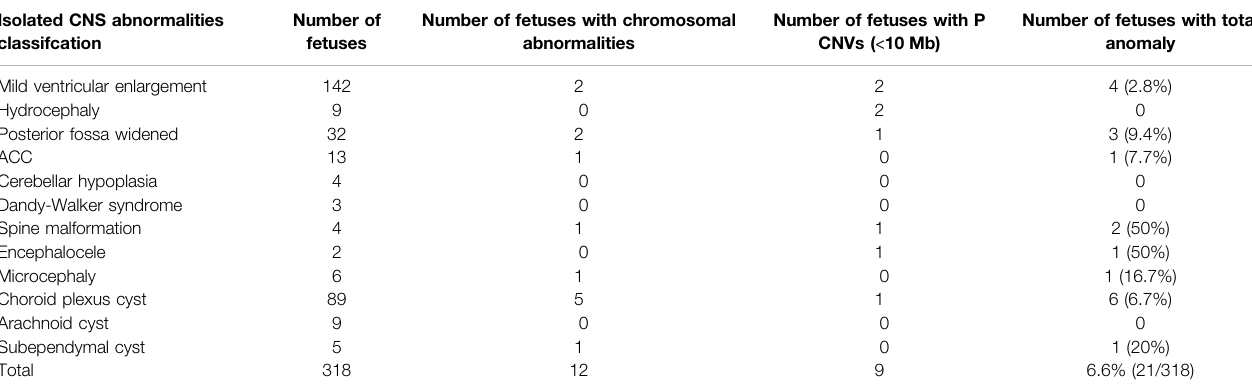
TABLE 6 | Phenotypic characteristics of 318 fetuses with isolated CNS